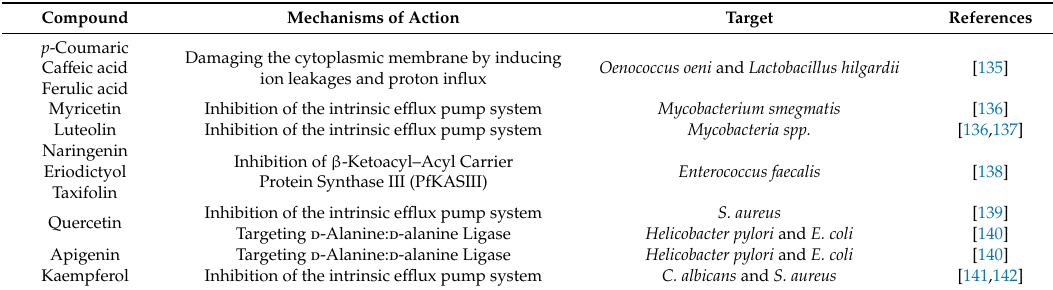
Table 5. List of e ff ective antimicrobial phenolic compounds derived from plants extracts.